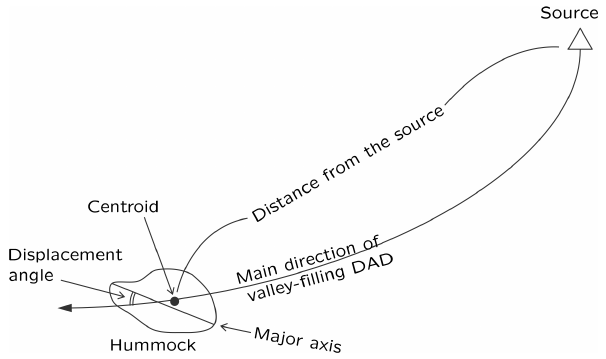
Figure 4. Definition of the displacement angle of a hummock (mod- ified after Yoshida,